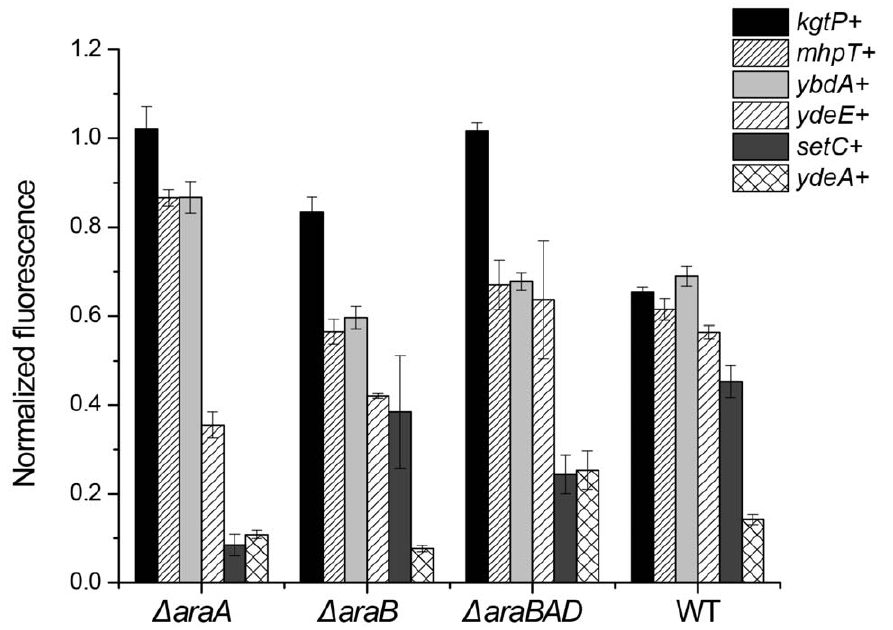
Figure 3. Overexpression of the efflux transporters in arabinose metabolic mutants. The data is normalized to the relative fluorescence values of the control strains (P araB - venus and pTrC99A in each of the individual arabinose mutants). All of the strains were induced with 5 mM arabinose. Overexpression of the the efflux transporters was induced with 2 mM IPTG except for the overexpression of setC and ydeE where 0.2 mM IPTG was used.